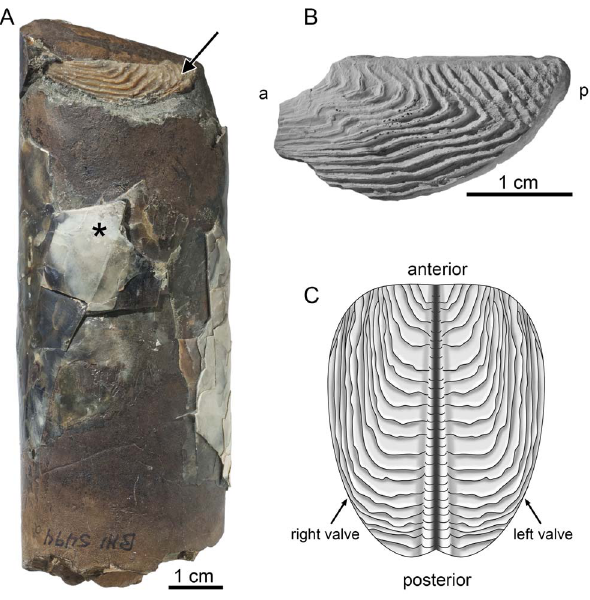
Figure 3. Ammonite shell material and aptychus jaw element. A) Baculites sp. (smooth) from the Pierre Shale, Butte County, South Dakota, with aptychus (arrow) preserved in the body chamber of the ammonite. Pieces of the aragonite shell (asterisk) are present on the steinkern. B) Reconstruction of the aptychus type of jaw in Baculites . The lower jaw is covered by two calcitic valves that usually separate after death and are found isolated in the sediment. C) Aptychus from the Mooreville Chalk, Alabama. Isolated valves are present in the sediment and are attributed to Baculites sp. (smooth). a-anterior,